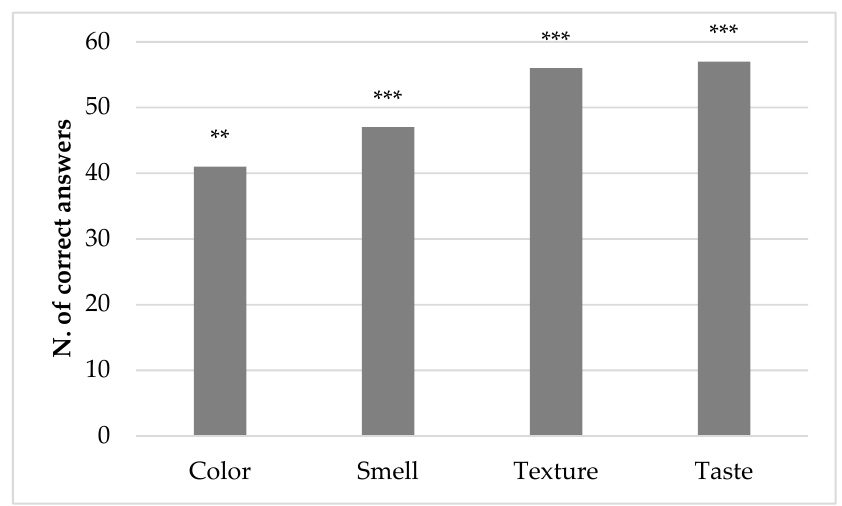
Figure 1. Number of people recognizing the difference between burger without fat substitution (CTRL) and at 100% fat substitution (T2) in a duo–trio consumer test. **: significance p < 0.01; ***: significance p < 0.001.